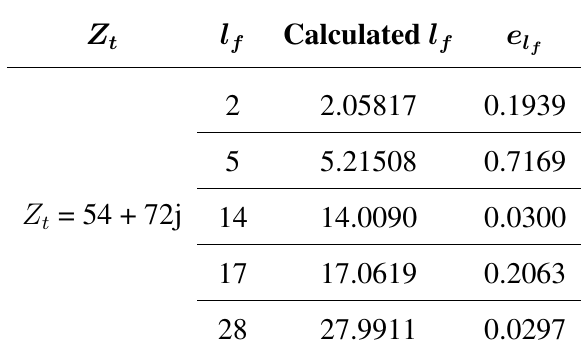
Table 3. The influence of locomotive load on the